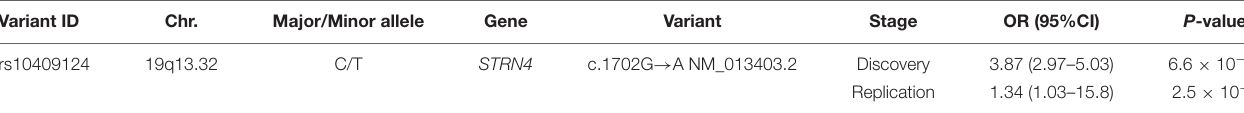
TABLE 2 | Markers associated with ACS identified by single-variant analysis. Chr.